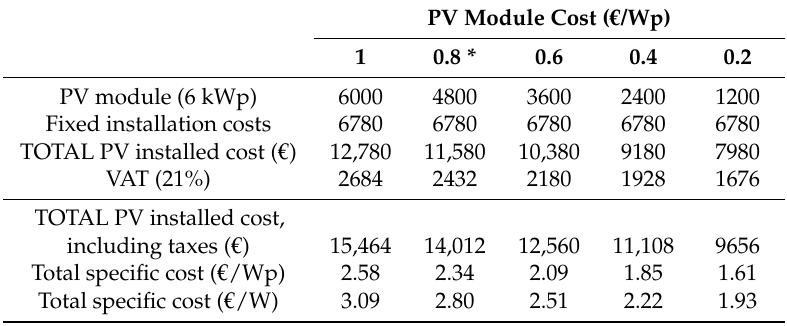
Table 3. Cost of a PV system at 6000 Wp (5000 W